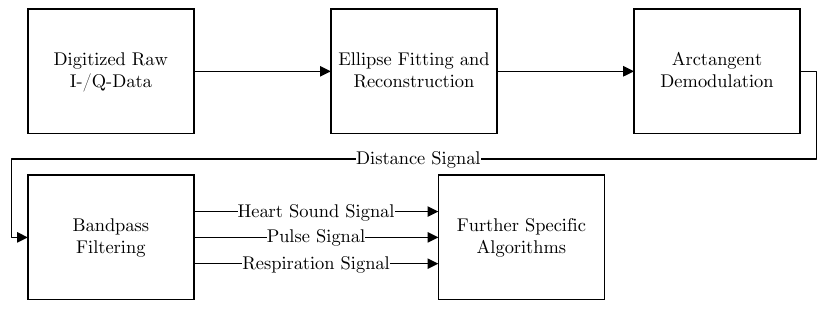
Figure 7. A flowchart showing the overall signal processing